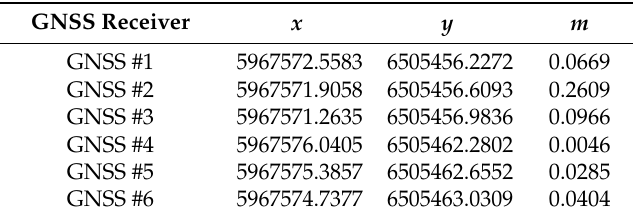
Table 2. Coordinates of GNSS receiver antennas along with the errors of their determination, obtained from satellite observations.